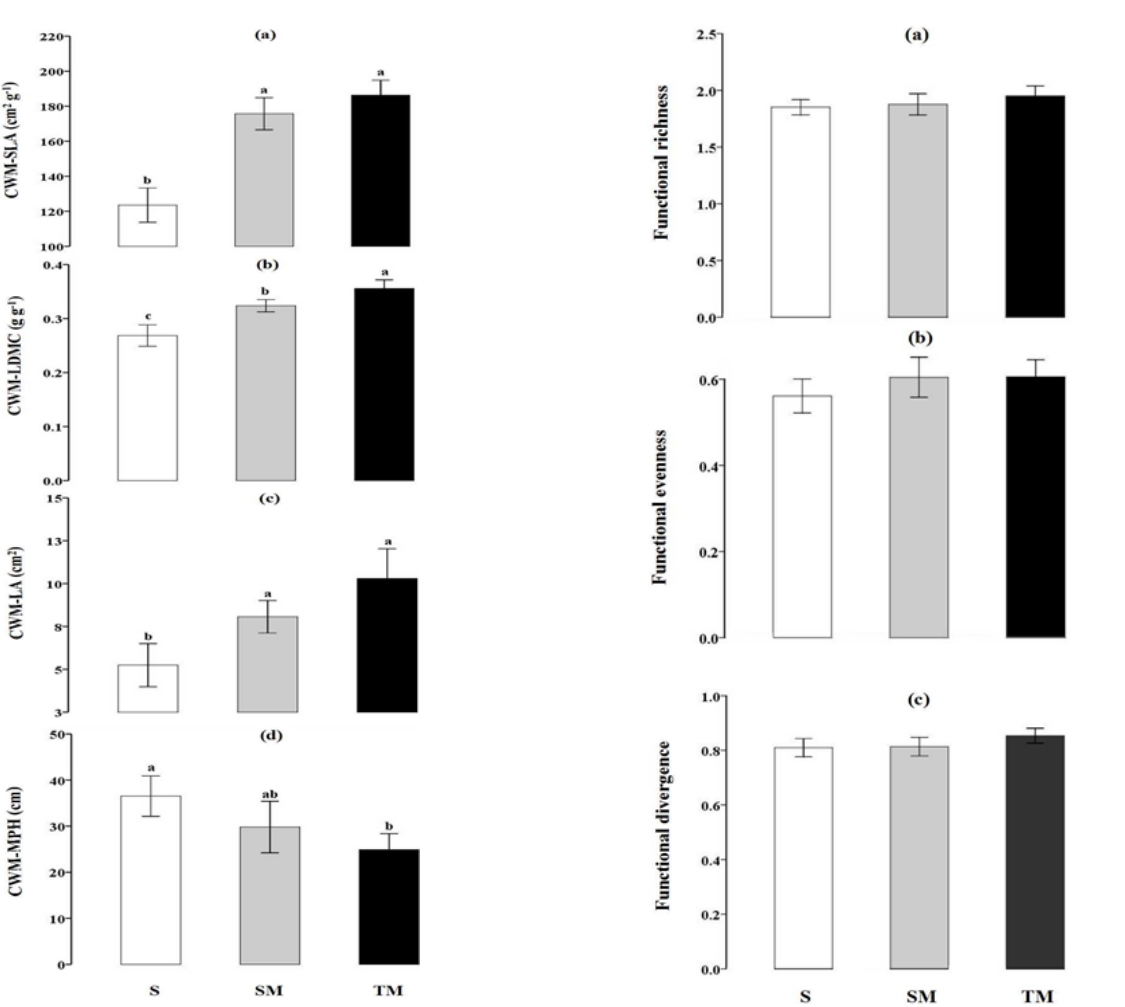
Figure 3. The changes in functional diversity (functional richness, functional evenness, and functional divergence) across three habi- tats. Significant differences indicated by dissimilar letters above each bar were determined using Tukey’s honest significant differ- ence (HSD) test ( P <0.05) after one-way